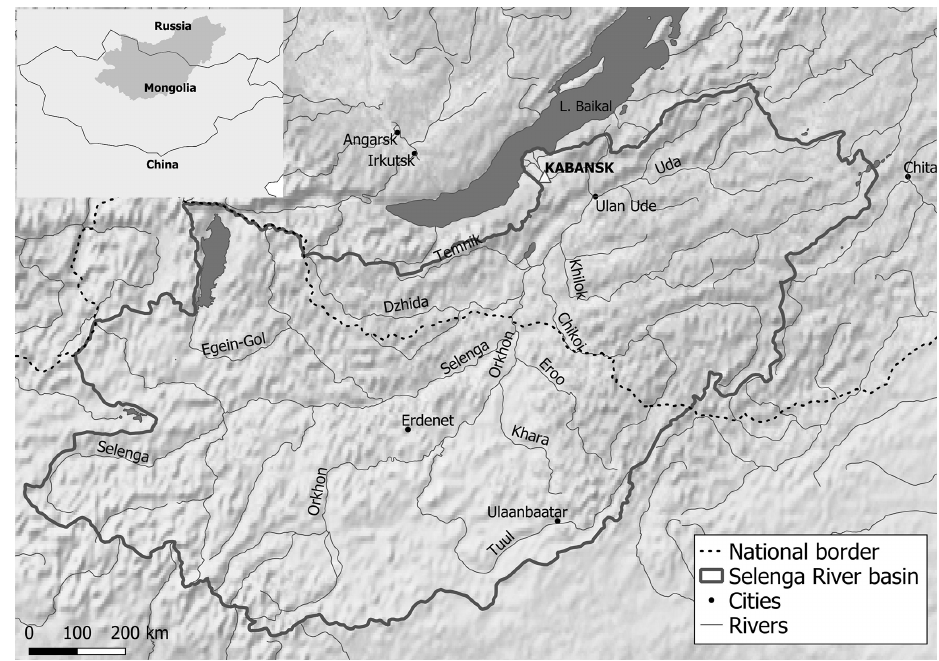
Figure 1. The Selenga River